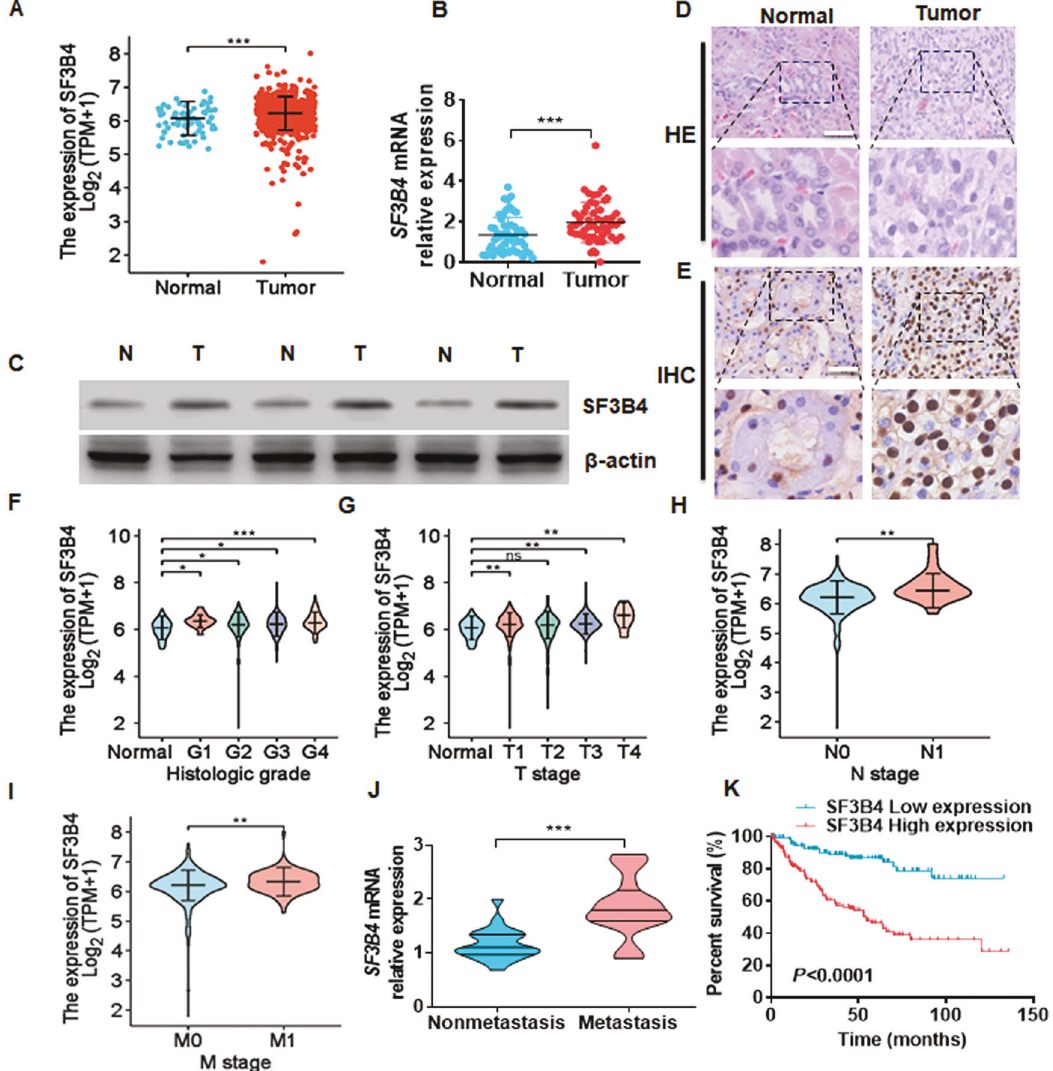
Fig. 1 SF3B4 is upregulated and negatively correlates with survival in patients with ccRCC. A The expression of SF3B4 was downloaded and then analyzed from the TCGA database in normal ( n = 72) and ccRCC ( n = 533) tissues. B The mRNA levels of SF3B4 were detected by RT- qPCR in total 53 clinical samples. C Three groups of ccRCC and normal renal tissue were randomly selected and western blot was used to detect SF3B4 protein expression. D Hematoxylin and eosin (HE) staining of tumor and normal kidney tissues. Scale bar = 50 μ m. E Immunohistochemical staining examined the SF3B4 expression in clinical samples. Scale bar = 50 μ m. F – I The mRNA levels of SF3B4 were compared with different clinicopathological parameters from TCGA ‐ KIRC: cancer versus normal tissues, G stage, T stage, N stage, and M stage. j RT-qPCR detected the SF3B4 expression in the ccRCC tissues of metastasis (n = 21) and non-metastasis ( n = 21). K Poor prognosis and low overall survival were associated with high SF3B4 expression in TCGA ‐ KIRC. All data are expressed as the mean ± SEM of three